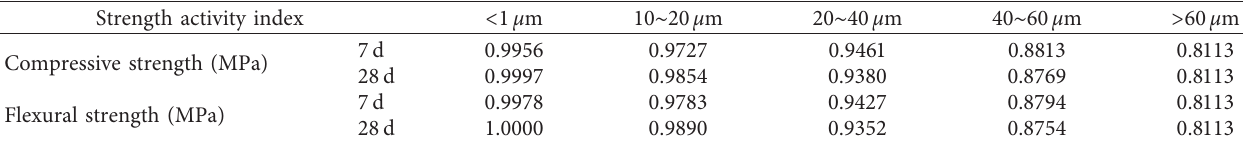
Table 6: Grey entropy of mortar strength activity index and BP particle